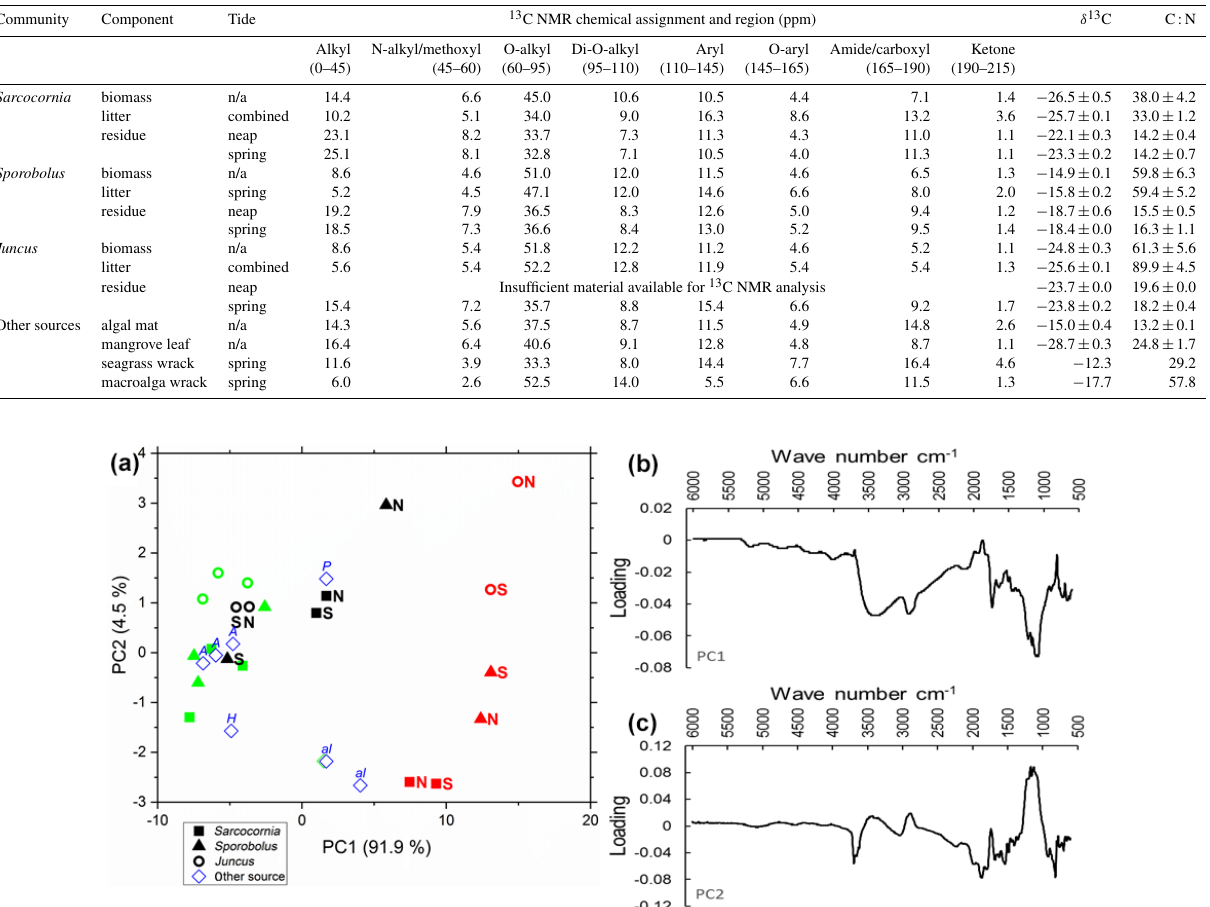
Table 2. Results of 13 C NMR, δ 13 C and elemental (C:N) analyses for each component of three salt marsh plant assemblages and other potential sources. 13 C NMR outputs are the average of two samples for each of the biomass and litter components (except Sporobolus litter, for which only one reliable spectrum was obtained). δ 13 C and C:N values are the mean ( ± SE) of biomass ( n = 3) and litter ( n = 4) samples. Residue samples were pooled from 15 filters in each vegetation assemblage. The tidal period was deemed not appropriate (n/a) for live biomass sample collection.